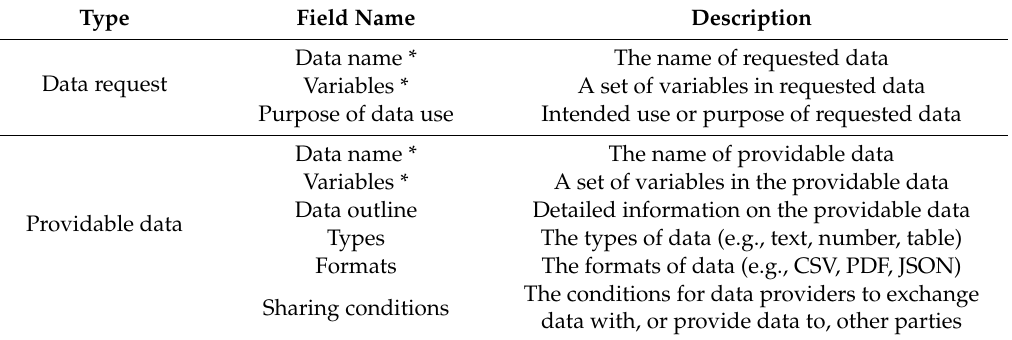
Table 1. Description items of data requests and providable data (* denotes a required